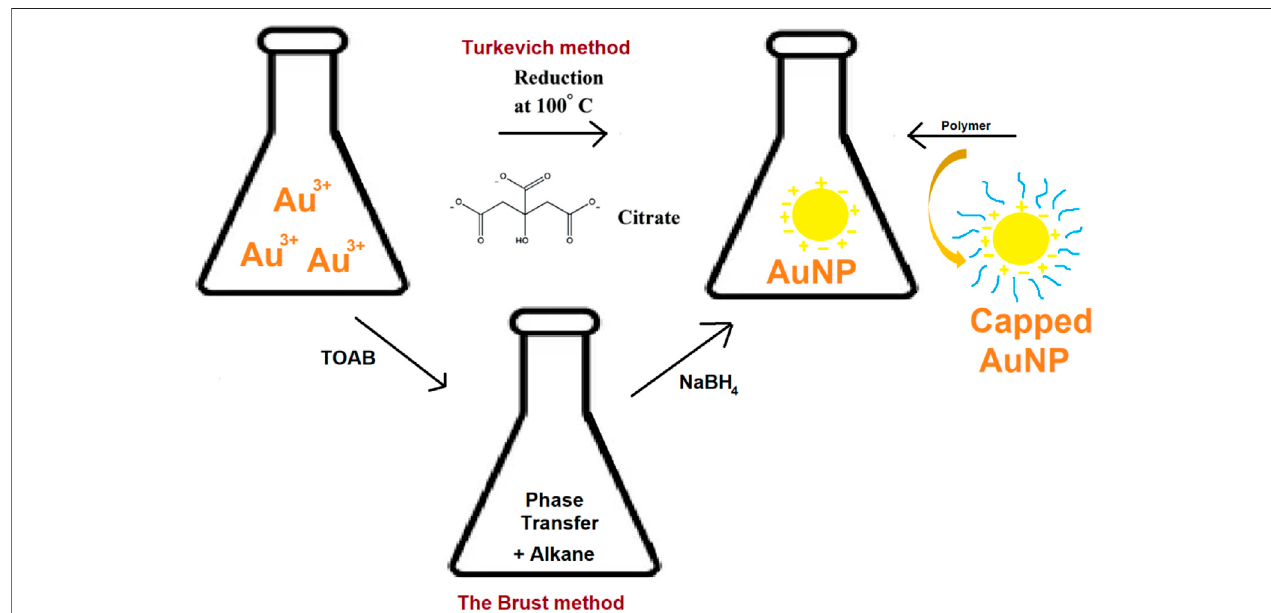
FIGURE 2 | Turkevich method, Burst method and polymer capped synthesis of AuNPs.